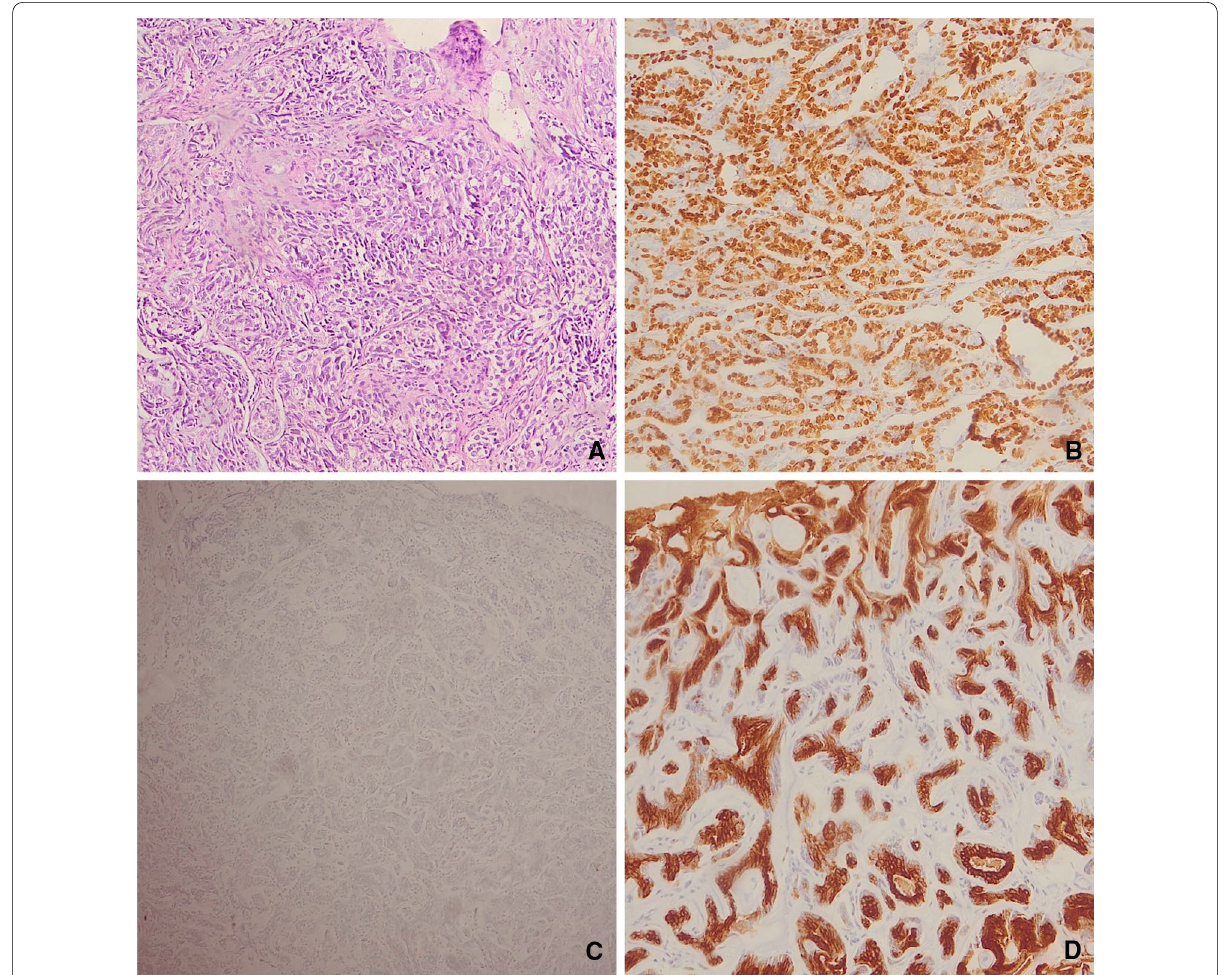
Fig. 1 a Cribriform pattern with large solid basaloid nests, b Expression of p63 by basal cells, c No PSA immunostaining, d Cytokeratin 7 expression by luminal cells